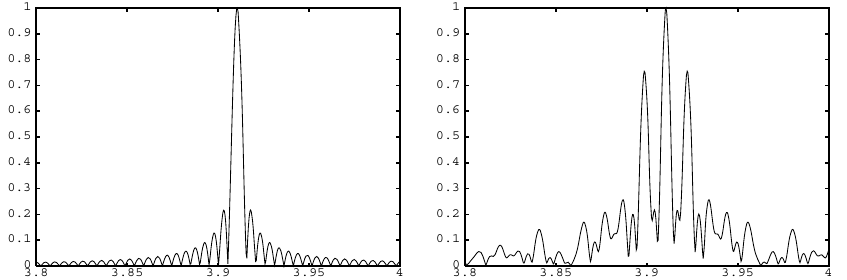
Fig. 2. The left panel shows the sampling function or “window func- tion” (in amplitude units) for a continuous light curve of 54 h duration. The right panel shows the window function for a light curve of the same length but with two day